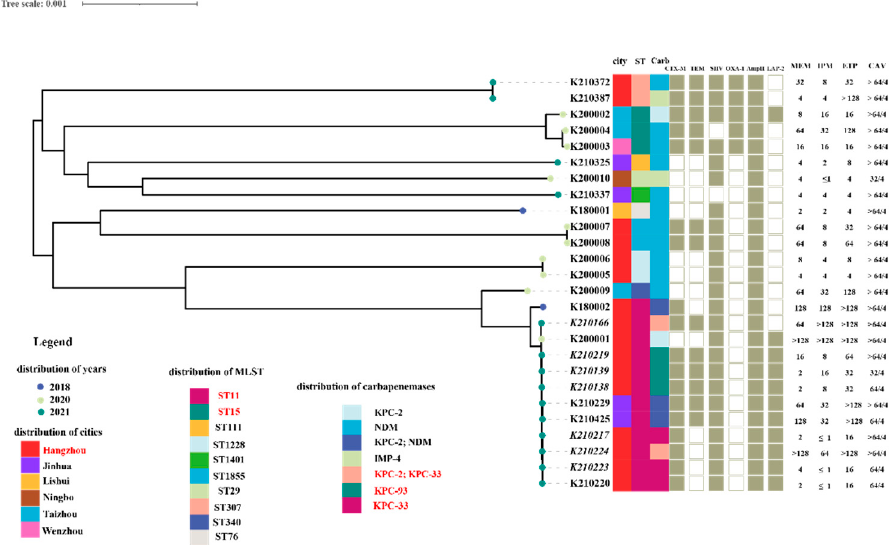
Figure 2. The overview of microbiological and molecular characteristics of 26 CAV-resistant CRKP isolates. It consisted of phylogenetic analysis, distribution of separation time, location, MLST, carbapenemases, the other β -lactamases and the antimicrobial susceptibility of carbapenems and CAV. The names of those strains whose patients were treated with CAV are shown in italics.